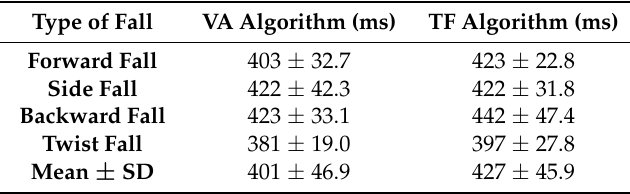
Table 5. Lead times based on VA and TF